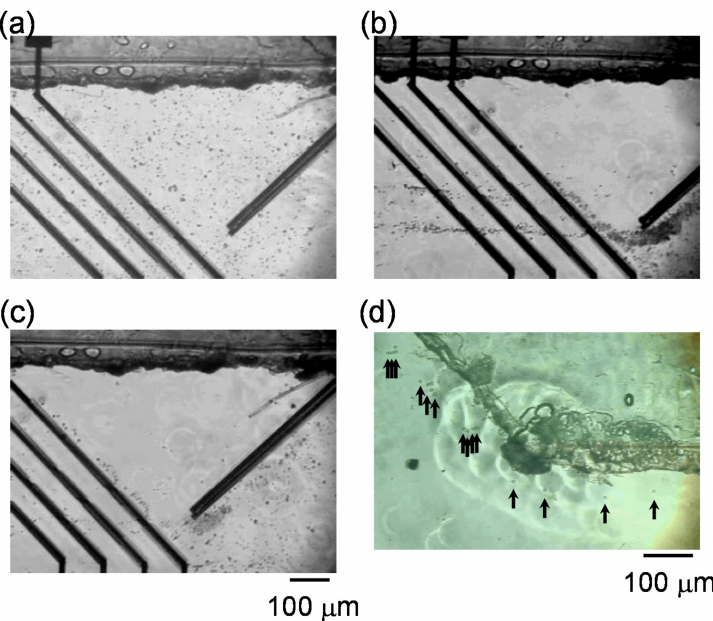
Figure 5. Images of RBCs and THP-1 cells flowing in the channel ( a ) before and ( b , c ) after applying AC voltage to both navigate electrodes and separate electrodes (i) and (iii). ( d ) Image of THP-1 cells guided from the main channel to the side